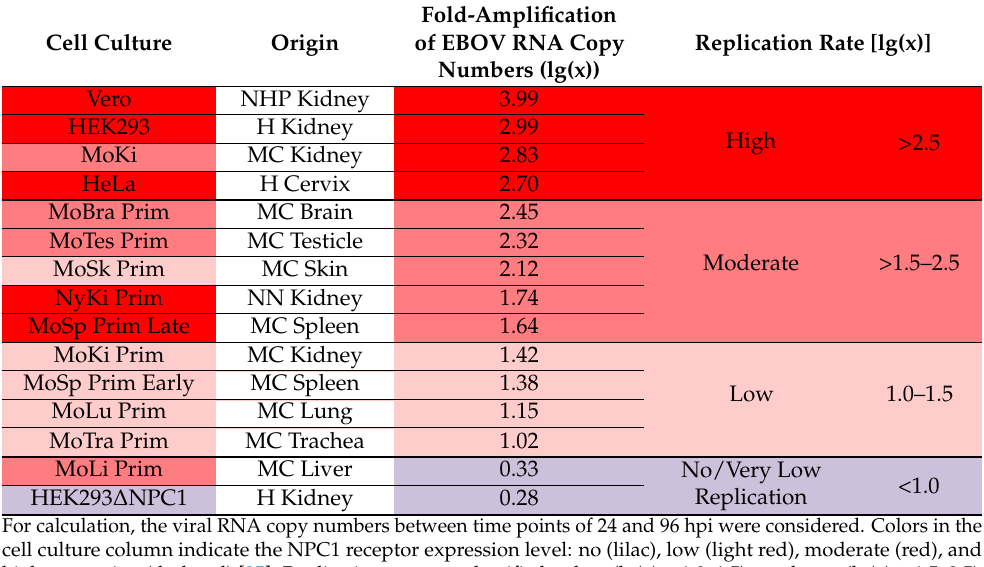
Table 1. List of cell isolates used, origin, and fold-amplification of EBOV RNA copy